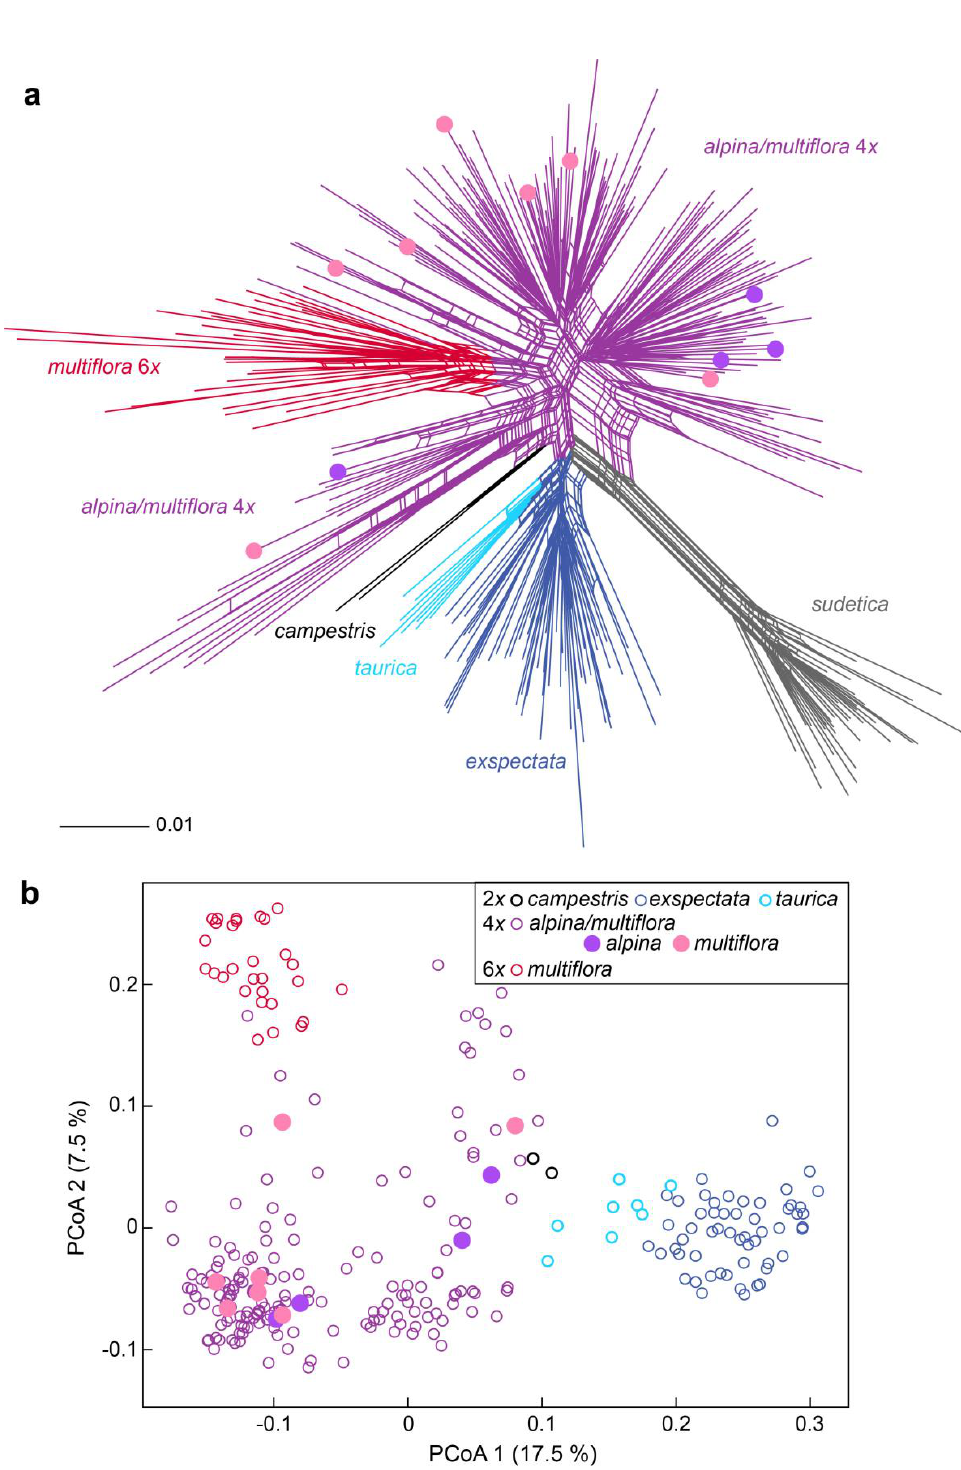
Figure 5. Genetic variation within mostly high-elevation Eastern Alpine species of Luzula sect. Luzula based on AFLP fingerprinting. ( a ) NeighbourNet; ( b ) Principal Coordinate Analysis scatterplot. Colors correspond to species/ploidy levels. Filled symbols indicate karyotyped individuals of L. alpina and L. multiflora .